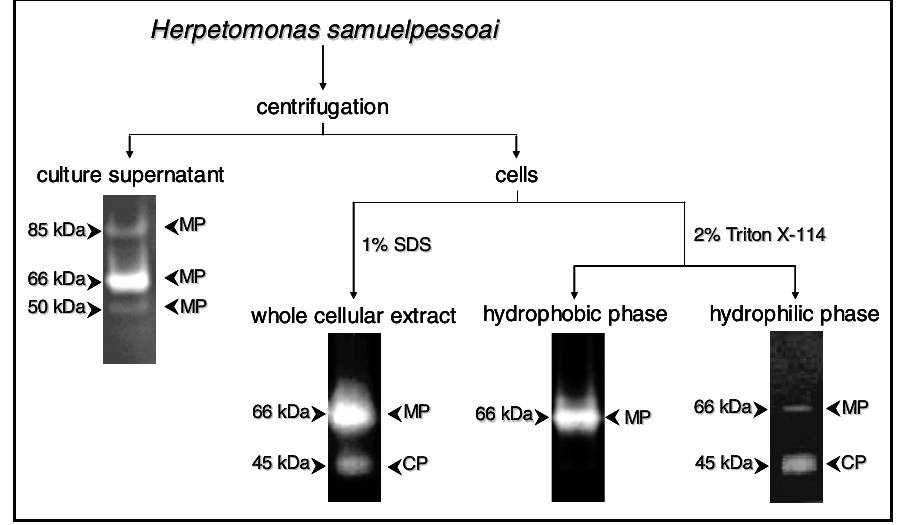
Fig. 2 – Extracellular and cell-associated proteolytic enzymes of Herpetomonas samuelpessoai cells. Parasites were cultured in a complexmedium(brainheartinfusion)for48hat26 ◦ C.Then,cellswereharvestedbycentrifugation,theculturesupernatantwasfiltered in Millipore membrane and concentrated 50-fold in Amicon system. The cells were lysed by: the addition of SDS, generating whole cellular extract, or by Triton X-114 to obtain the hydrophilic (cytoplasmatic and intravesicular fraction) and hydrophobic (membrane fraction) phases. The extracellular and cellular extracts were applied on gelatin-SDS-PAGE to evidence the proteolytic enzymes. MP, metalloprotease and CP, cysteine protease. For experimental details see Santos et al. 2002a, 2003. Note that the 66 kDa proteolytic enzyme, presenting metalloprotease activity, was mainly detected in the culture supernatant (extracellular environment) and in the membrane fraction, while a minor proportion was also evidenced in the intracellular